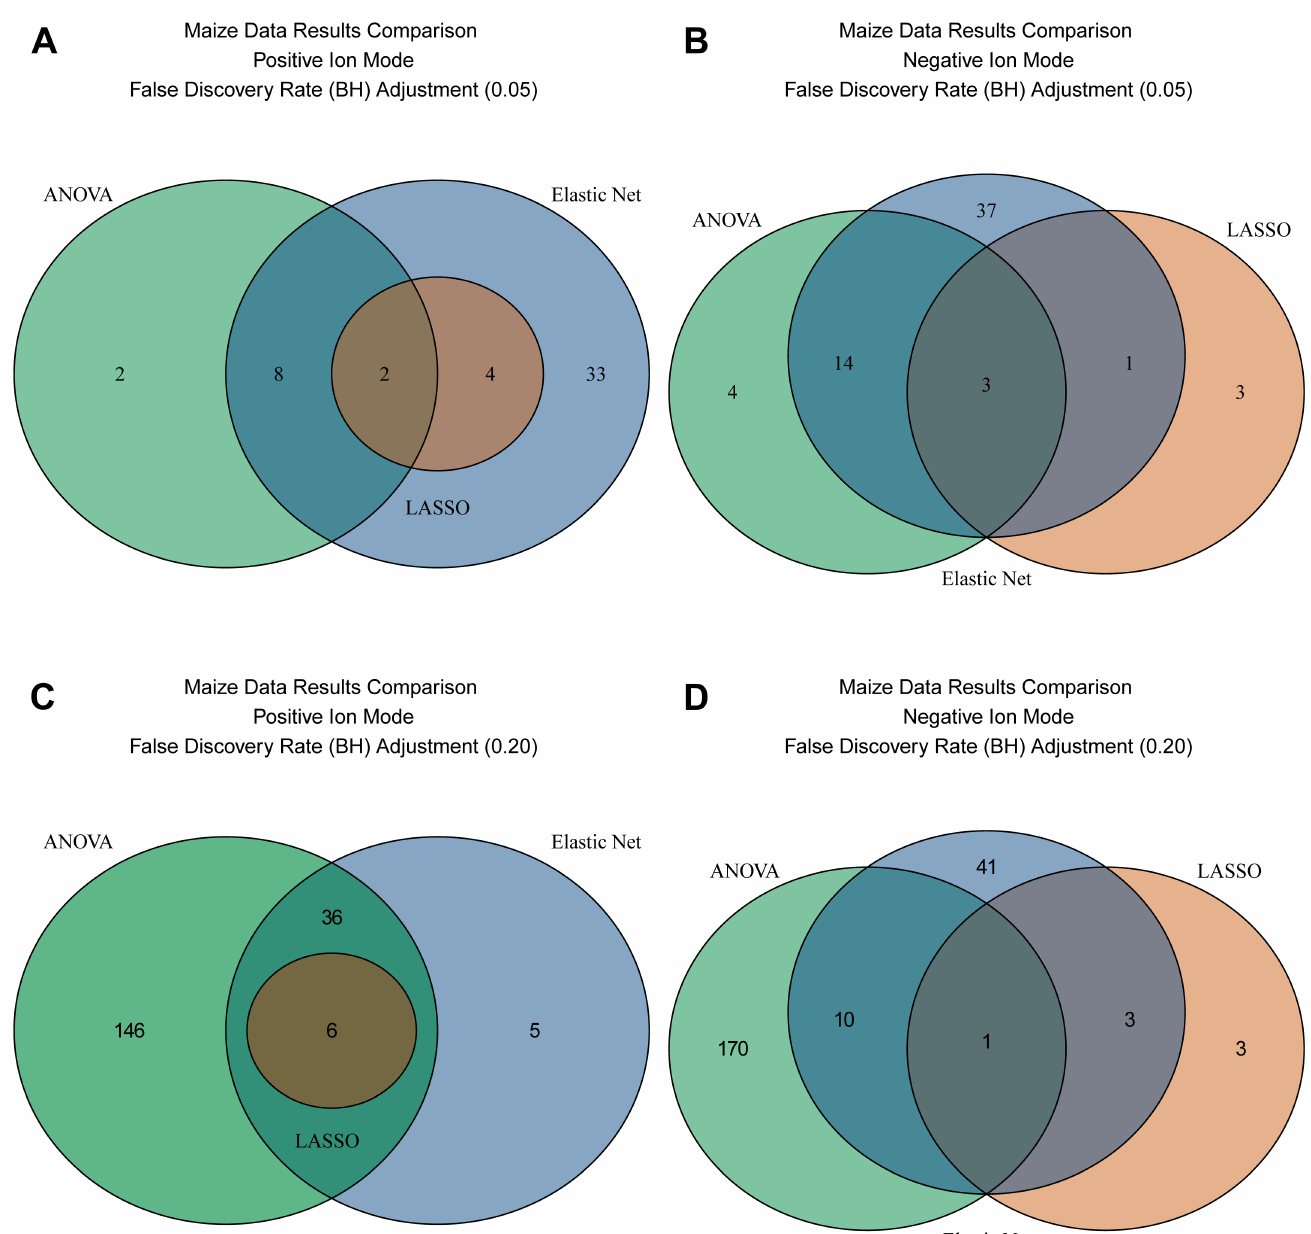
Fig 4. Visualization of power and Type I error estimates comparison for p = 2050 features, correlation ρ = 0.4, and all sample sizes. Each row of the plots corresponds to a feature selection method. ANOVA FDR adjustment cutoff is 0.2. The value of the sample size ( n ) is displayed on the x -axis in all plots. The estimates of power and Type I error are provided on the y -axis. In the left column power estimates are provided based on the four different features for each of the effect sizes ( Δ 1 = 0.2 is the red line, Δ 2 = 0.5 is the blue line, and Δ 3 = 0.8 is the green line). In the right column Type I error estimates are provided (beige lines) based on the random noise features together with a 0.05 threshold plotted as a purple dashed line. In the middle column the proportions of non-different detected features within each block correlated to different ones for each of the blocks and corresponding effect sizes ( Δ 1 = 0.2 is the red line, Δ 2 = 0.5 is the blue line, and Δ 3 = 0.8 is the green line) are